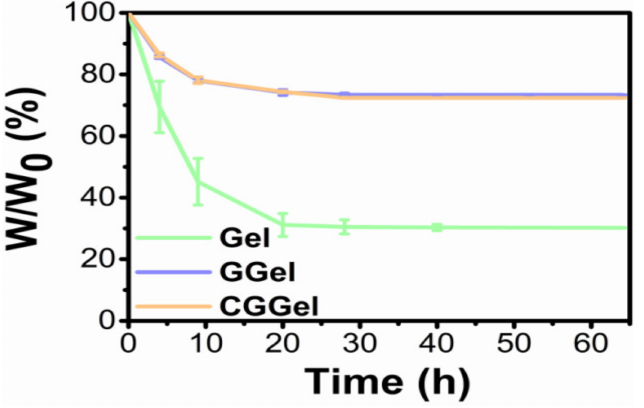
Figure 7. Weight loss plots of the hydrogels. Data are represented as the mean ± SD ( n = 3).